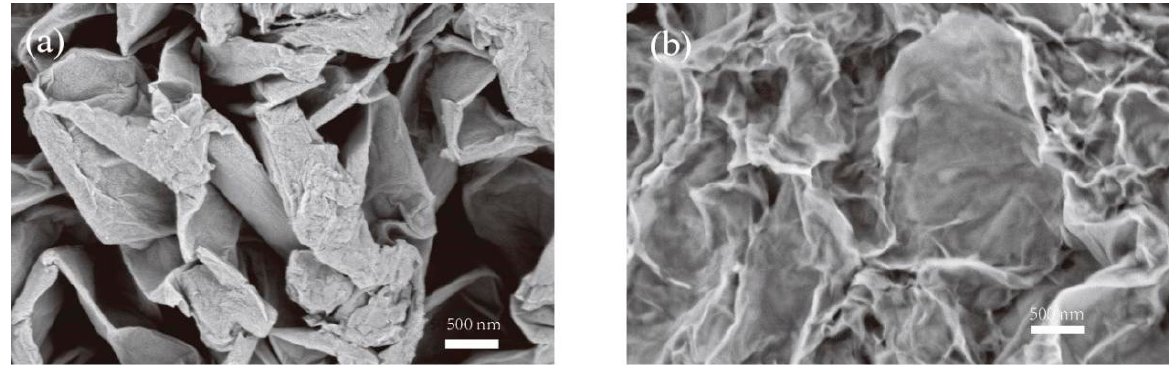
Figure 2. SEM images of ( a ) graphene oxide (GO), ( b ) reduced graphene oxide (rGO)